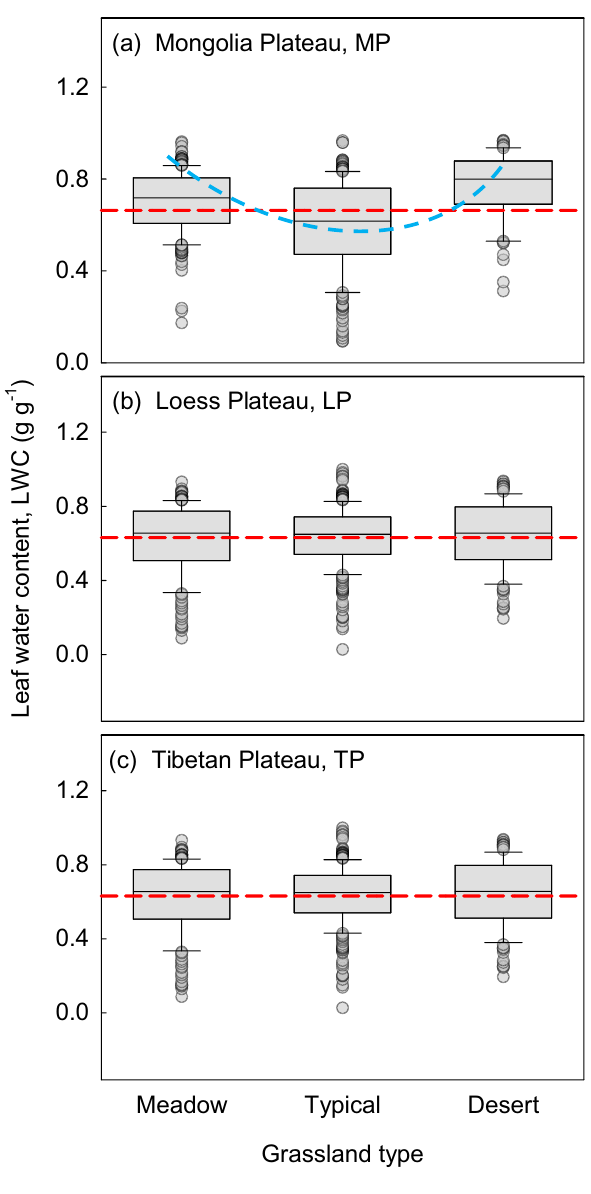
Figure 2. Changes to leaf water content (LWC) in different grassland types. Panels ( a ), ( b ) and ( c ) show the LWC on the Mongolia Plateau (MP), Loess Plateau (LP), and Tibetan Plateau (TP). Red dotted lines present the mean in each plateau, and blue dotted lines present virtual trends. Figures were done by SigmaPlot version